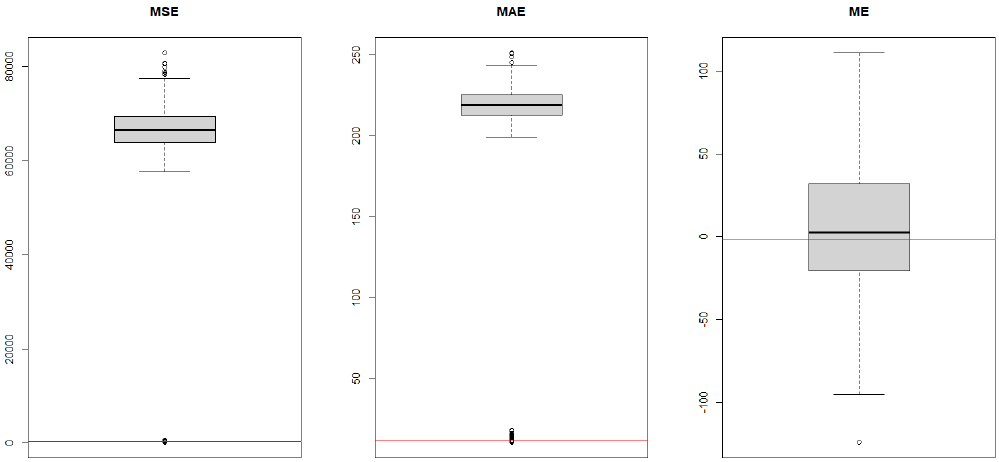
Figure A2. Box plots displaying the MSE, MAE and ME of 300 fully trained neural networks using the same hyperparameters. MSE, MAE and ME evaluated with respect to the (Sobol) validation set. Figures of the ensemble of 10 best performing neural networks added in